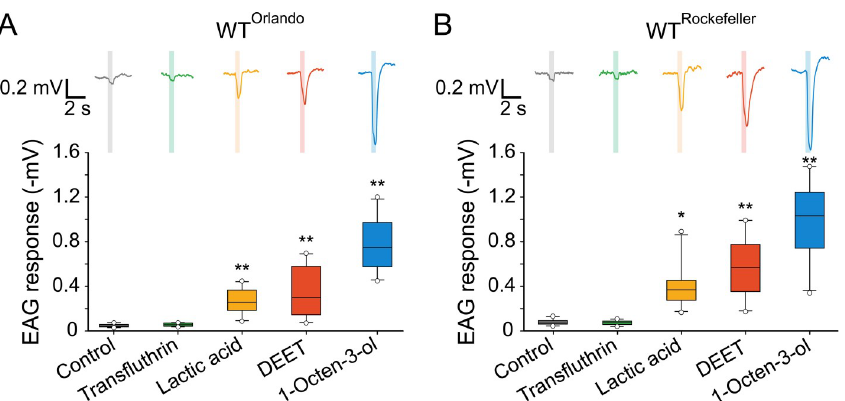
Fig 2. Transfluthrin does not elicit electroantennogram in Ae . aegypti . Electroantennogram performed with two wild-type lines, Orlando (A) and Rockefeller (B). A representative trace is shown above each plot; the asterisks ( � P < 0.05, �� P < 0.01) indicate significant differences against control within each mosquito line, Friedman RM ANOVA on Ranks, χ 2 = 46.49, df = 5, P < 0.001 for Orlando (A), and χ 2 = 43.83, df = 5, P < 0.001 for Rockefeller (B); n = 10 antennae. Boxes represents the 25 th , 50 th and 75 th , whiskers the 10 th and 90 th , and white circles the 5 th and 95 th percentiles of the data.